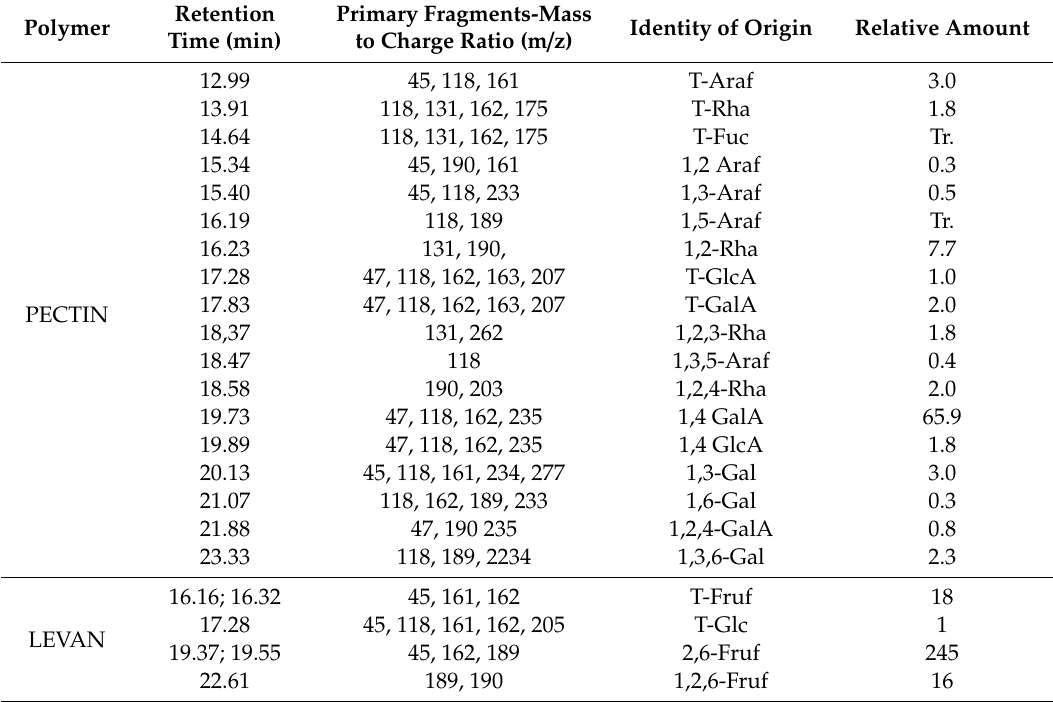
Table 5. Pectic and levan linkages obtained from GC-MS from the cucurbit polysaccharide fractions. Retention time is the elution time of the partly acetylated, partly methylated alditol acetates, obtained during the methylation process. “T” refers to the terminal